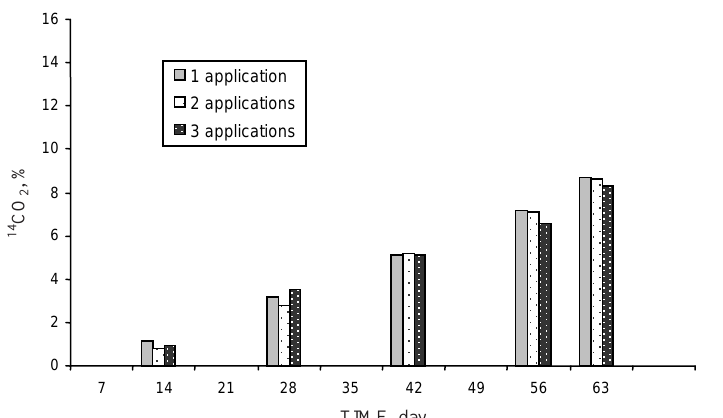
Figure 3. Mineralization of 14 C-metalaxyl after one, two or three successive applications of a commercial formulation of metalaxyl in LE soil samples (cumulative percentage of 14 CO